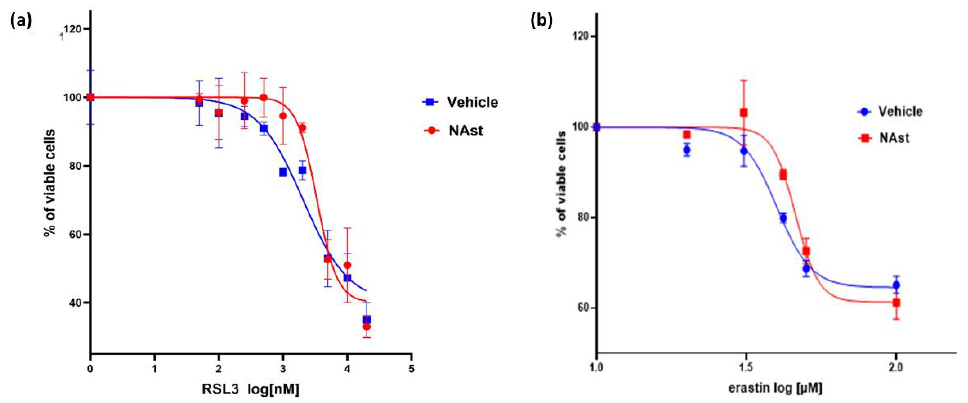
Figure 4. Viability of SHSY-5Y cells in the presence of different concentrations of the ferroptosis inducers RSL3 and erastin. Cells were supplemented with 3.7 ng/µL of NAst or vehicle for 24 h and subsequently treated for 24 h with different concentrations of the ferroptosis inducers RSL3 ( a ) and erastin ( b ). Data are reported as the percentages of viable cells ± SDs in comparison to controls; n = 3. Cell viability was determined by the MTT assay, as described in the Material and Methods